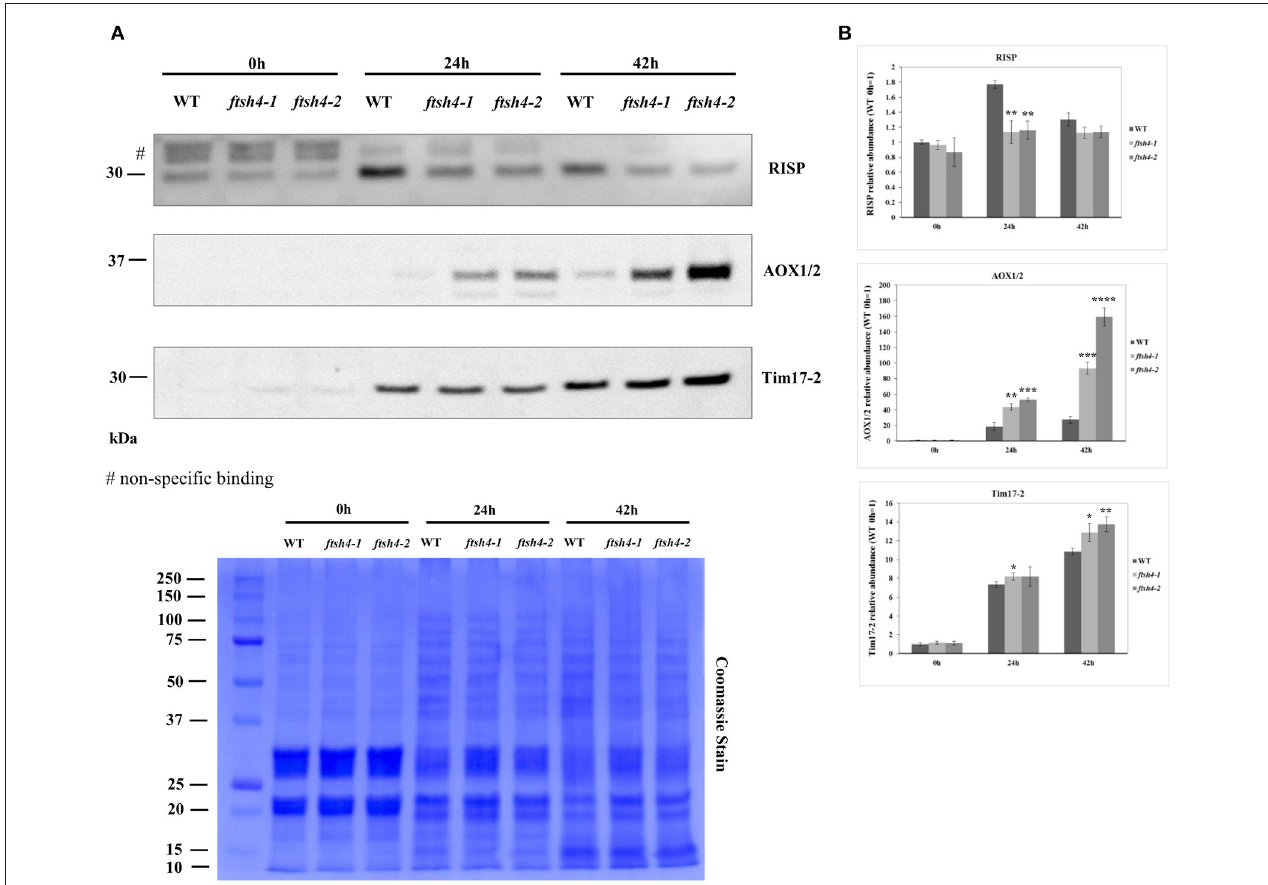
FIGURE 9 | Western blot analysis of selected mitochondrial proteins in ftsh4-1 and ftsh4-2 mutant seeds in comparison to those of wild-type. In all experiments, seeds were stratified for 48h at 4 ◦ C in the dark and then incubated for 24 and 42h under LD conditions at 30 ◦ C. 40 µ g of total seed protein extract was loaded on 12% SDS-PAGE. (A) Representative immunoblots with mitochondrial proteins detected after stratification (0h) and after 24 and 42h of germination at 30 ◦ C (24, 42h). Representative membrane stained with Coomassie Brilliant Blue (CBB) is presented to show an equal loading. (B) Quantification of the abundance of the analyzed proteins. Protein amount was quantified densitometrically using ImageJ (Fiji) based on immunodetection with antibodies directed against selected proteins as well as Ponceau S or CBB staining of the membrane as a loading control. The abundance values are given as relative of the value obtained for WT 0h seeds (set as 1). Data are mean ± SD of three independent biological replicates. * p ≤ 0.05; ** p ≤ 0.01, *** p ≤ 0.001; **** p ≤